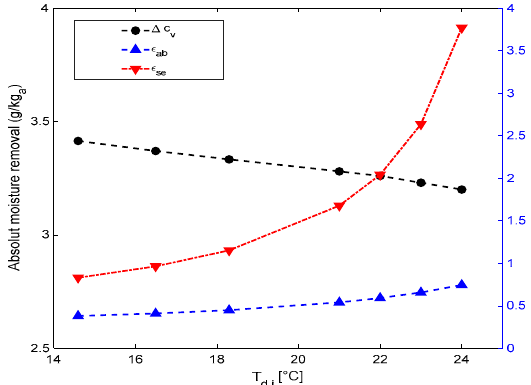
Figure 7. Effects of the temperature of the inlet LiCl solution on the absolute moisture removal, absorption, and sensible effectiveness parameters.